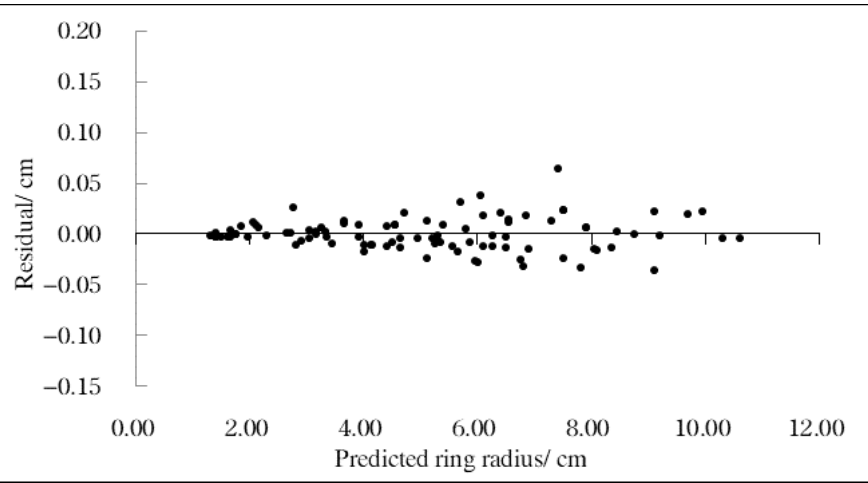
Figure 8. Residual diagram of the polynomial regression correction model.